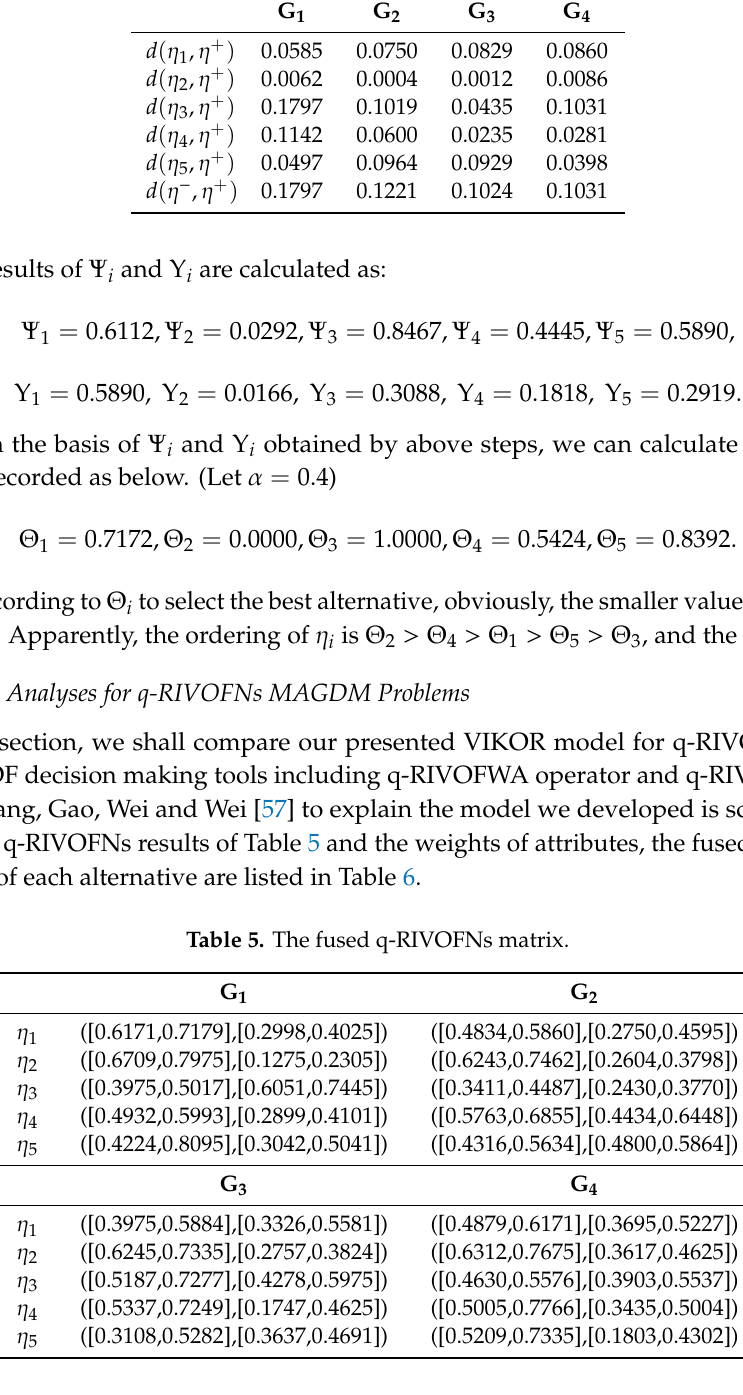
Table 6. The fused results of each alternative η